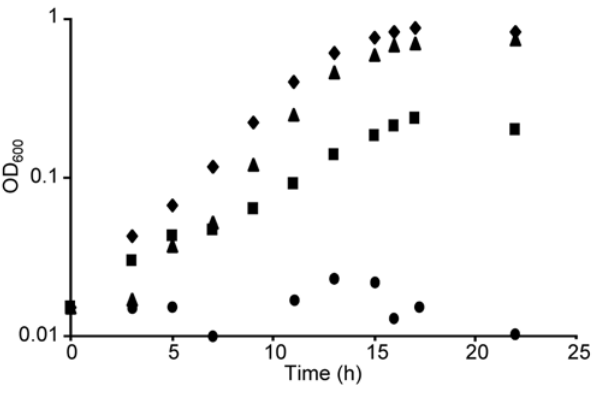
Figure 2. LctD is required for growth using L-lactate. Growth curves of wild-type A. actinomycetemcomitans and the A. actinomyce- temcomitans lctD insertion mutant in chemically defined medium (CDM) containing 20 mM glucose or 20 mM L-lactate as the sole source of energy. Glucose-grown A. actinomycetemcomitans ( ¤ ), L-lactate-grown A. actinomycetemcomitans ( m ), glucose-grown A. actinomycetemcomi-